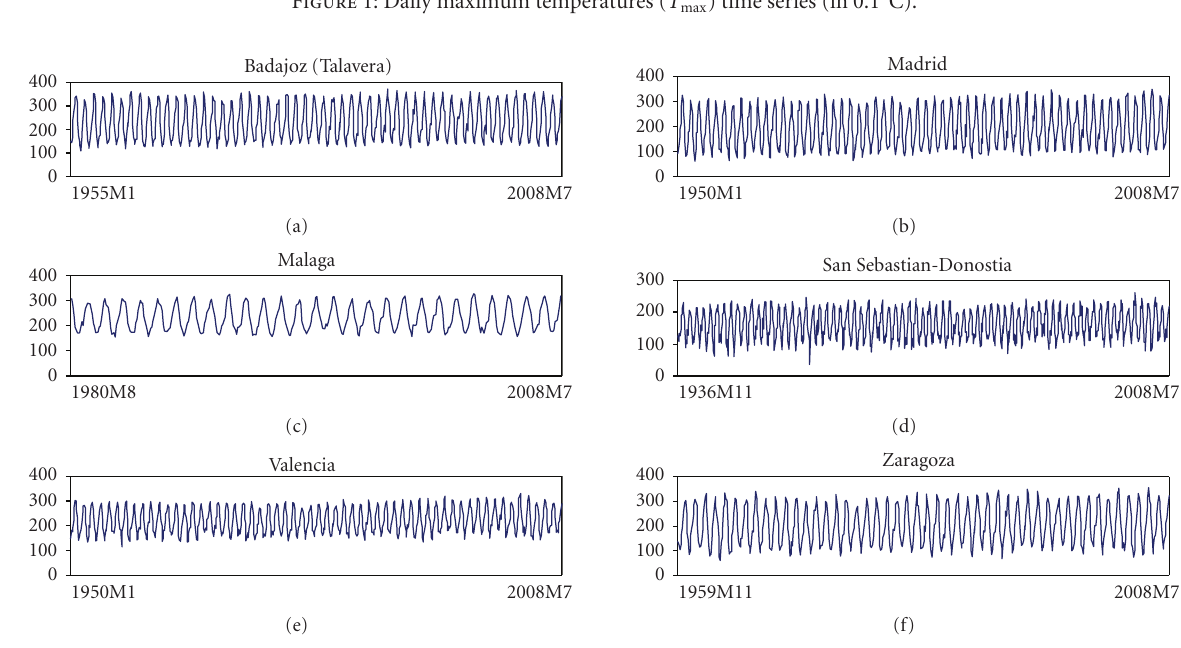
Figure 2: Monthly mean maximum temperatures ( T max ) time series (in 0.1 ◦